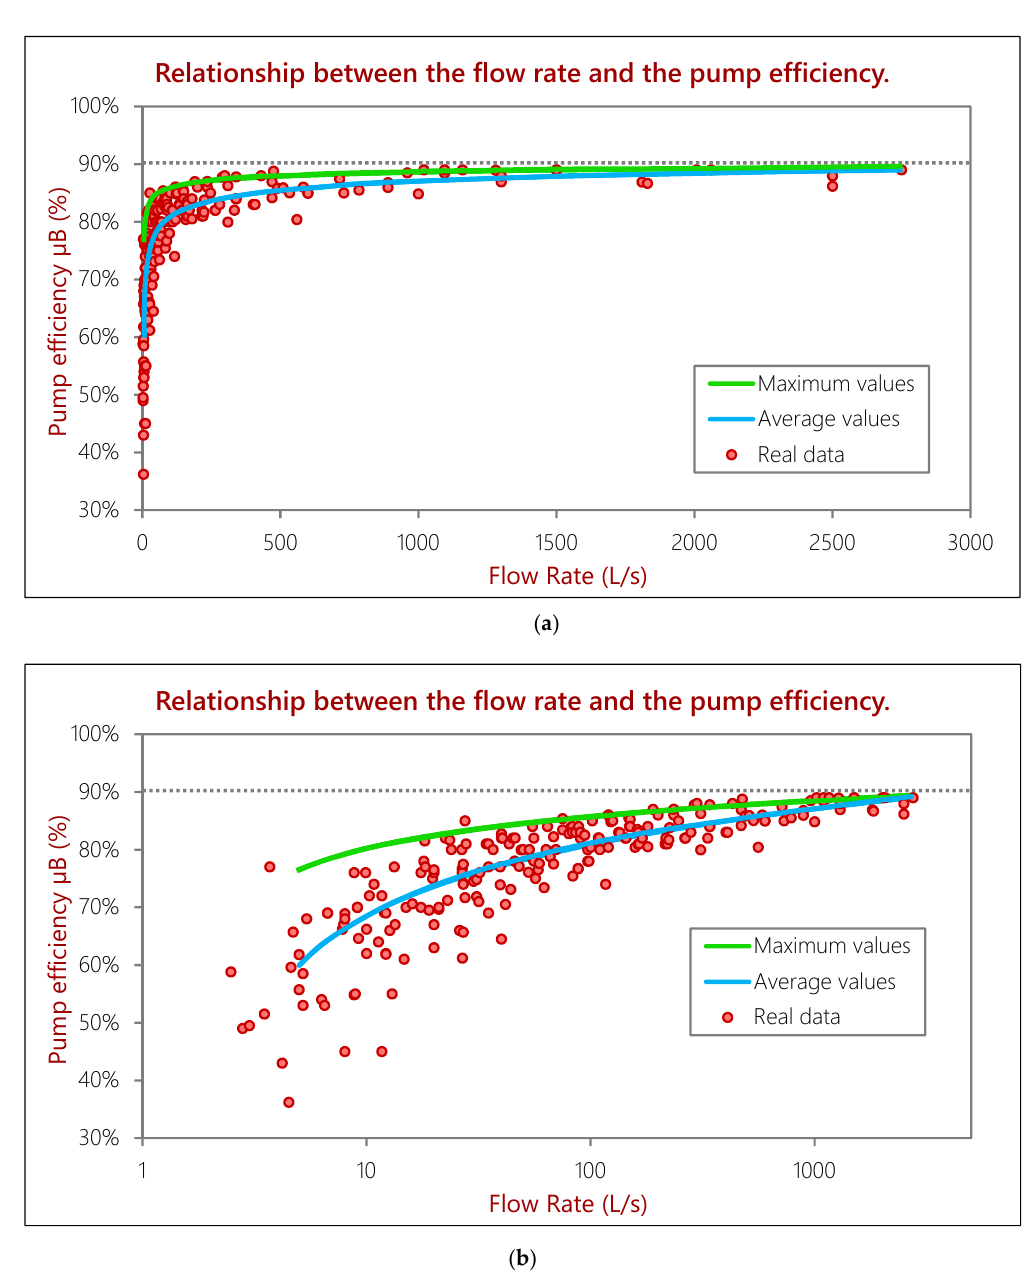
Figure 6. ( a ) Optimum pump efficiency curve: database and mathematical adjustment; ( b ) mathematical adjustment in logarithmic scale.